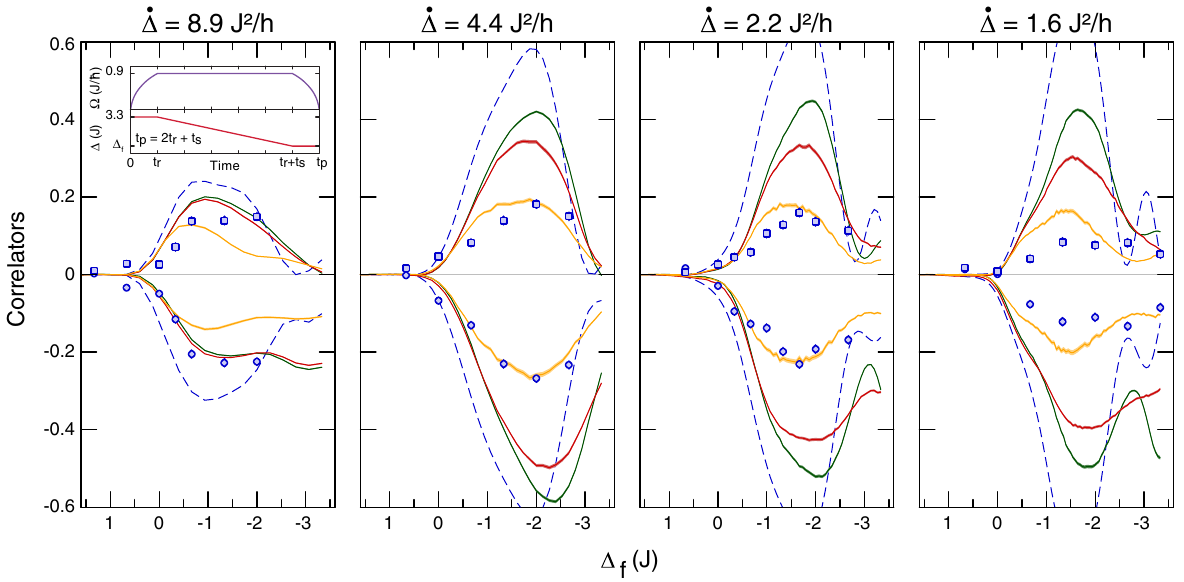
FIG. 3. Time evolution of spin correlations after near-adiabatic quenches and comparison with phenomenological decoherence models: experimental correlations after near-adiabatic quenches [blue circles for C ð 0 ; 1 Þ and blue squares for C ð 1 ; 1 Þ ] for different quench rates (left to right panels) and varying final detuning Δ f . These are compared with MCWF simulations taking into account different types of decoherence (lines). We studied T 1 type decoherence with T 1 ¼ 20 μ s (green) and T 2 type decoherence with T ¼ 0 . 5 μ s (red). The T T 2 1 value is chosen as the lifetime of the Rydberg state and the 2 value is an aggressive lower bound given by our Ramsey calibration [44]. Additionally, we show the combination of T 1 decoherence with two-particle “ interaction noise ” for nearest- neighbor pairs (yellow). For the latter, the decoherence rate ( Γ J ¼ 1 μ s − 1 ) was a free parameter chosen to obtain reasonable agreement with experimental correlations for all four quenches simultaneously [44]. The shaded regions depict the standard error of the mean of the simulations. For reference, the calculations without decoherence are also shown (dashed blue lines). Inset: Time dependence of the Rabi frequency Ω and detuning Δ used for the near-adiabatic quenches. The time for switching on and off the laser coupling was fixed to t r ¼ 0 . 6 h=J for all quenches. The maximum total length of the quench t p varies from 0.3 to 0 . 9 μ s, depending on the quench